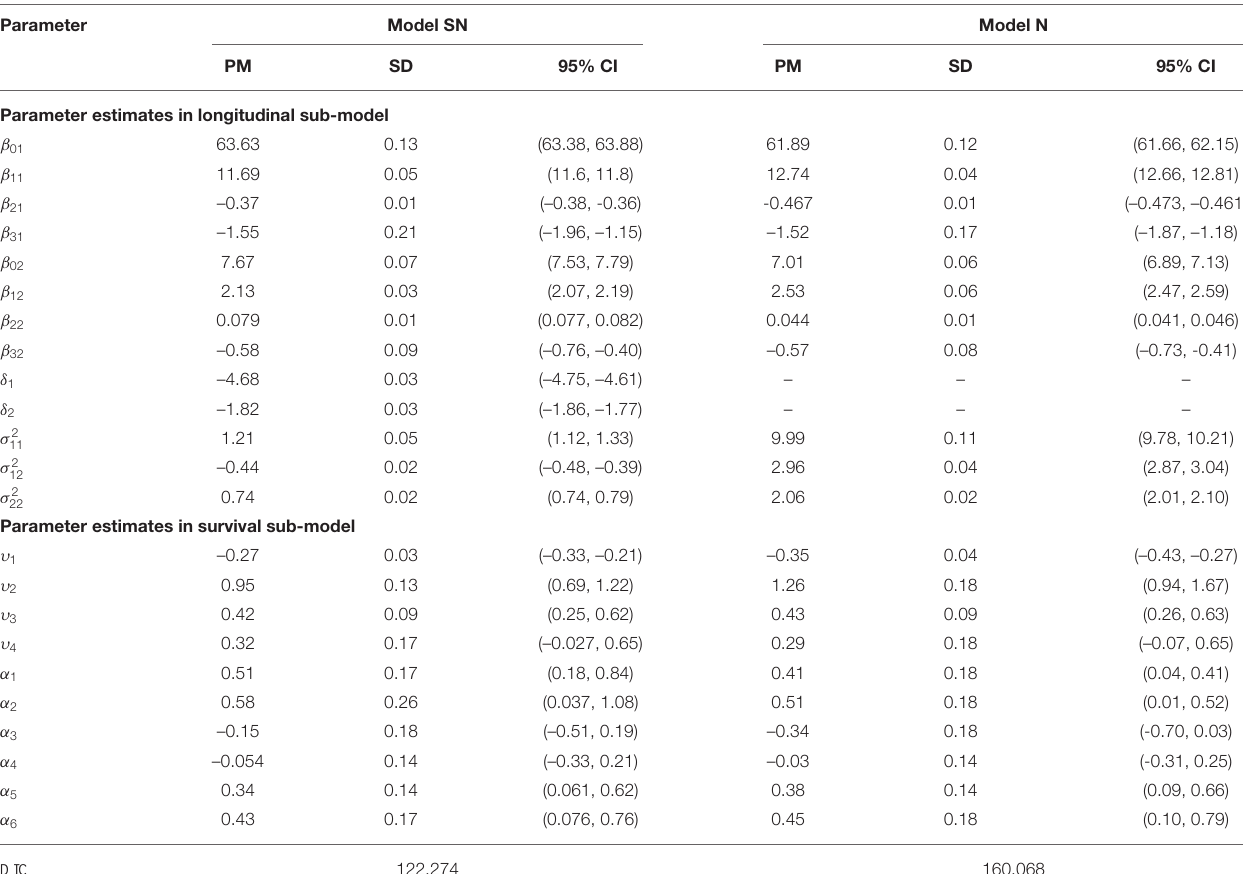
TABLE 1 | Summary of the estimated posterior mean (PM) and standard deviation (SD) of the population (fixed-effects) parameters, and the corresponding 95 % equal-tail credible interval (CI) as well as deviance information criterion (DIC) values. Parameter